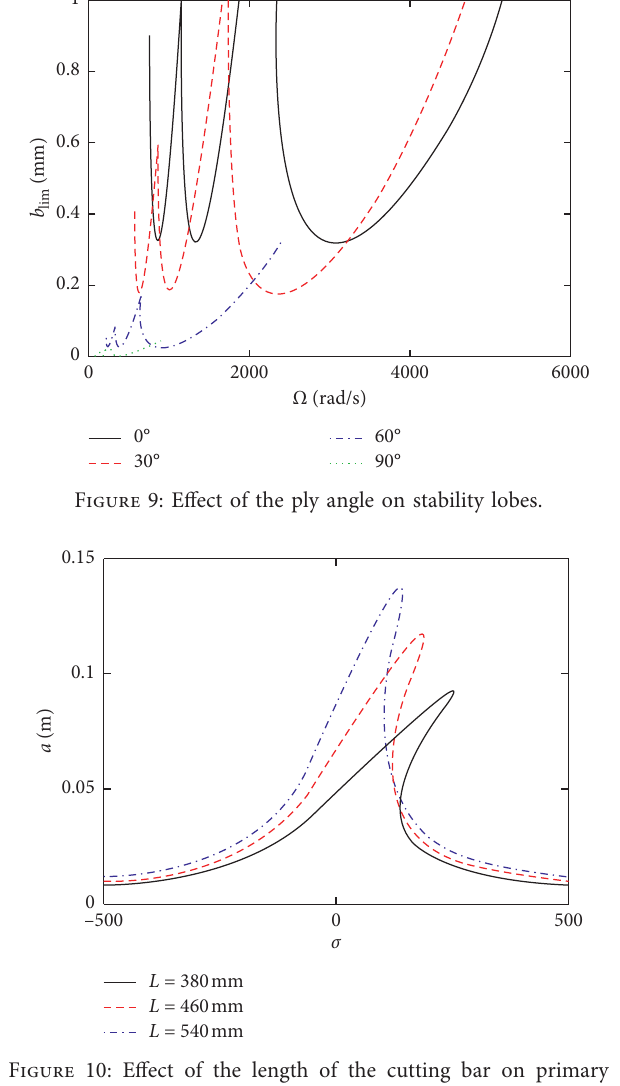
Figure 13: Effect of the cutting force parameter on primary res- onance